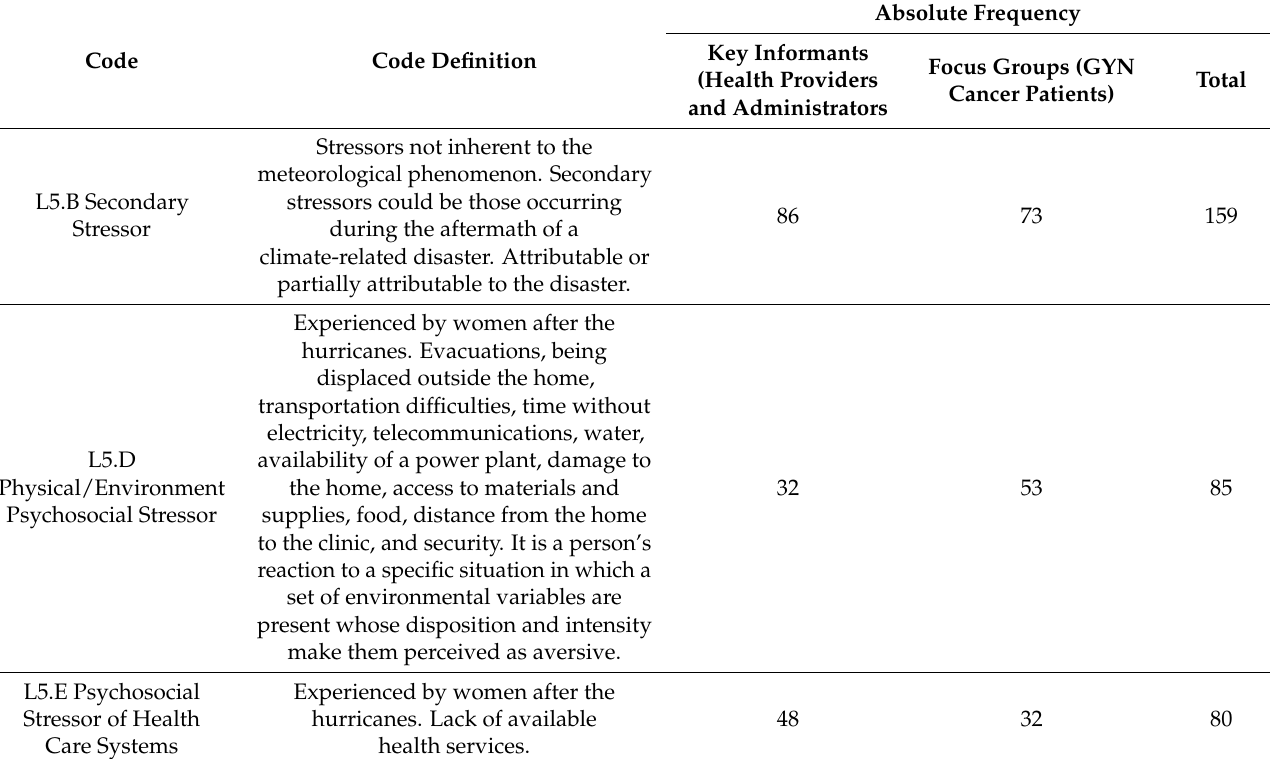
Table 1. Code L5: Primary and secondary environmental